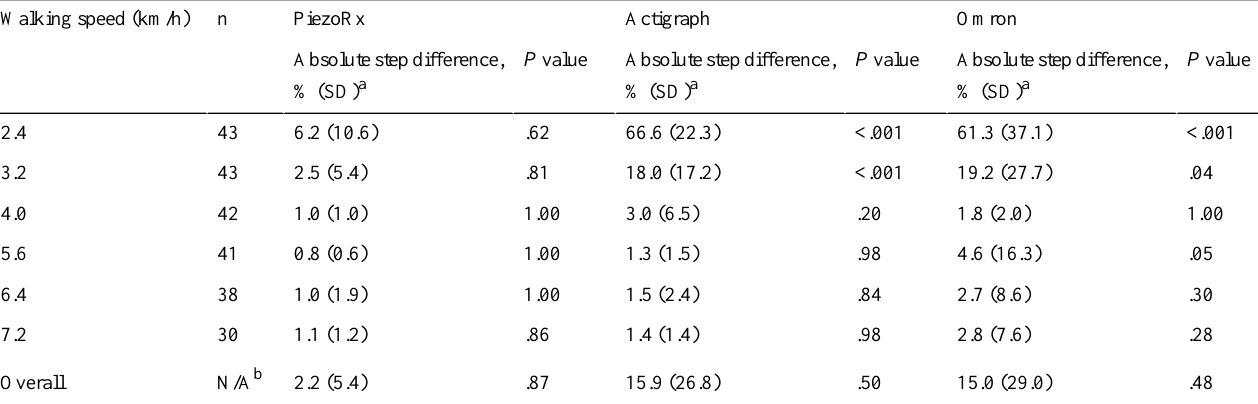
Table 4. Absolute step difference between manually counted steps and steps measured using each device during treadmill walking. OmronActigraphPiezoRxnWalking speed (km/h)